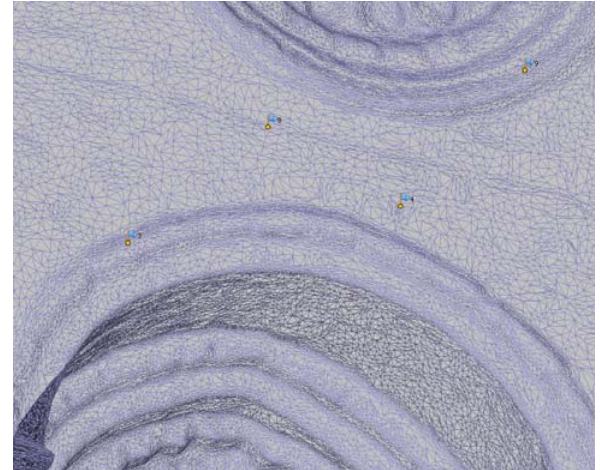
Figure 13. Mesh detail: vertices are closer each other in zones with more complex geometry so faces are smaller just